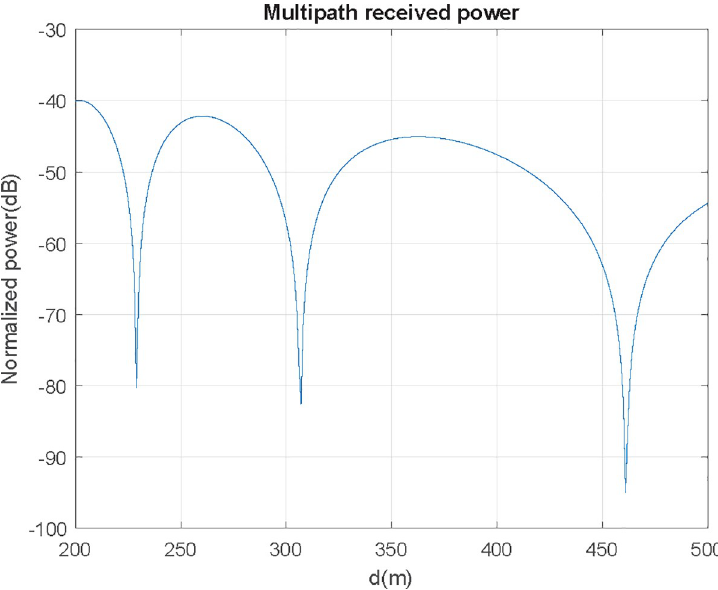
Fig 17. Power received in a multipath scenario for f = 300 MHz, h UAV = h AUT = 21.5 m.